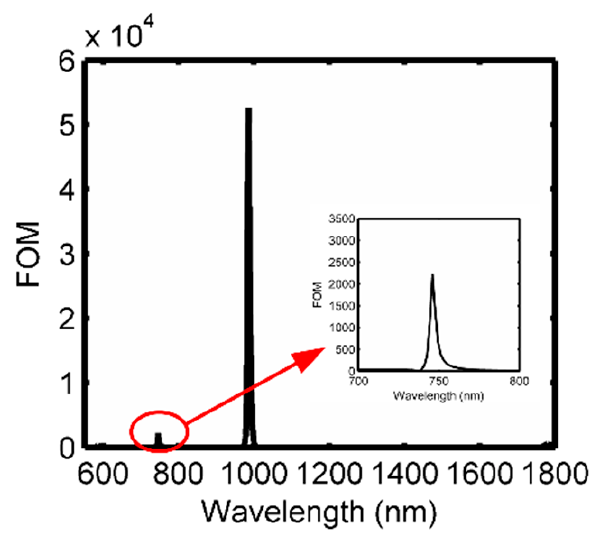
Figure 4. FOM values of the proposed structure, and the sub-graph inside is the magnified area around the Fano dip wavelength.